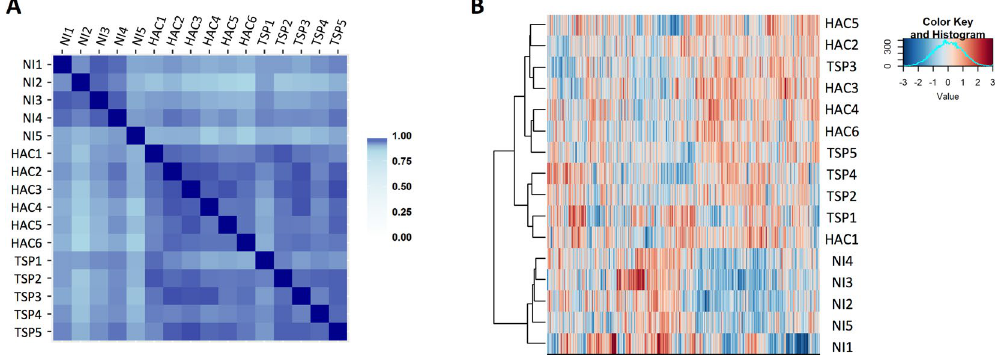
Figure 2. Protein cargo composition distinguishes between HTLV-1 infected donors and non-infected donors. ( A ) Pair-wise correlations between samples. Shades of blue represent correlation values. ( B ) Hierarchical cluster analysis between replicates using Ward’s method with a correlation-based